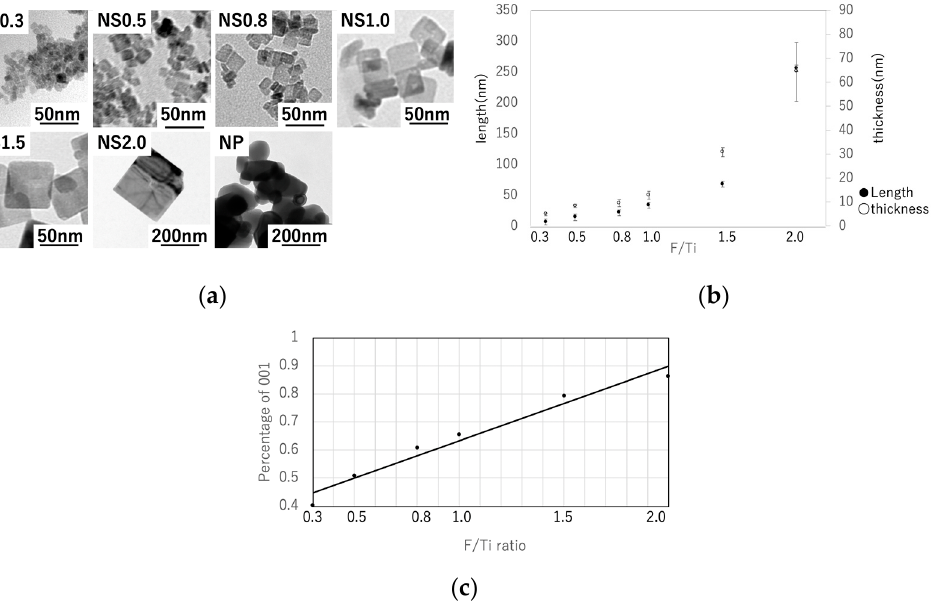
Figure 2. ( a ) TEM images of various TiO 2 nanosheets and NPs. ( b ) Length and thickness of each TiO 2 sample measured from TEM images. ( c ) Ratio of the {001} facet (P 001 ) calculated from the length and thickness.